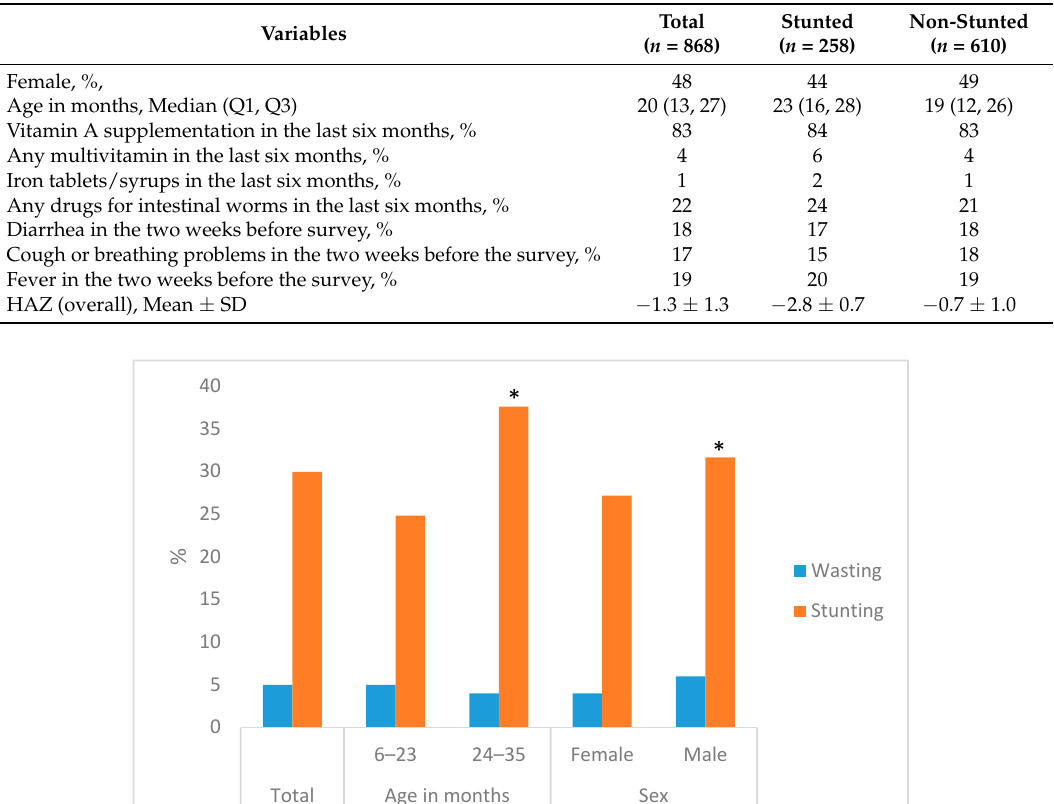
Table 2. Children’s health characteristics.